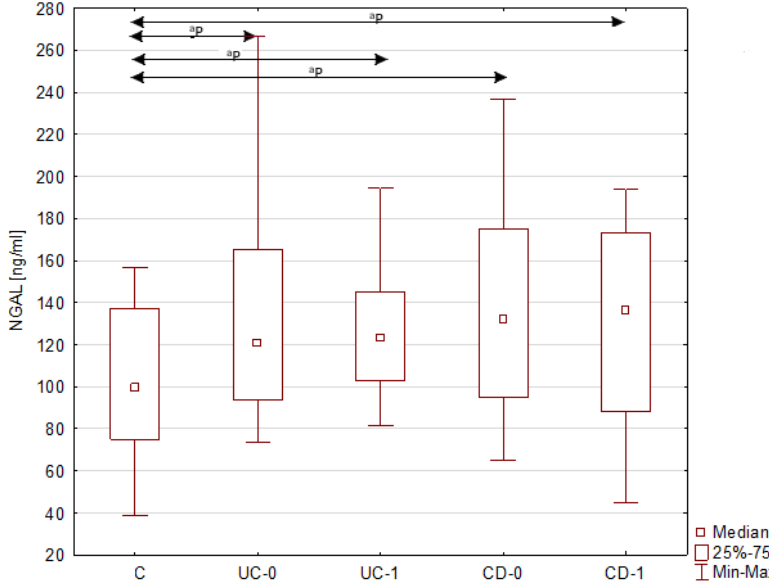
Figure 1. ( A – C ) Serum concentration of laminin (LM), fibronectin (FN) and neutrophil gelatinase-associated lipocalin (NGAL) in healthy individuals and patients with inflammatory bowel disease before and after a year of treatment. Presented results are expressed as median, interquartile range (25th–75th percentile), minimum and maximum of data in each group. CD-0, patients with Crohn’s disease before anti-inflammatory treatment; CD-1, patients with Crohn’s disease after a year of anti-inflammatory treatment; C, control; UC-0, patients with ulcerative colitis before Adalimumab treatment; UC-1, patients with ulcerative colitis after a year of Adalimumab treatment. a p < 0.05, b p < 0.01, c p < 0.005, d p < 0.001 statistically